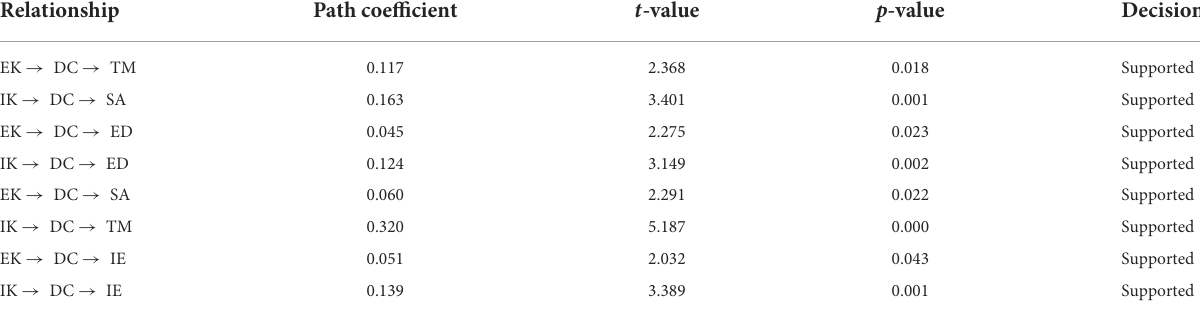
TABLE 8 Verification of the indirect path relationships.